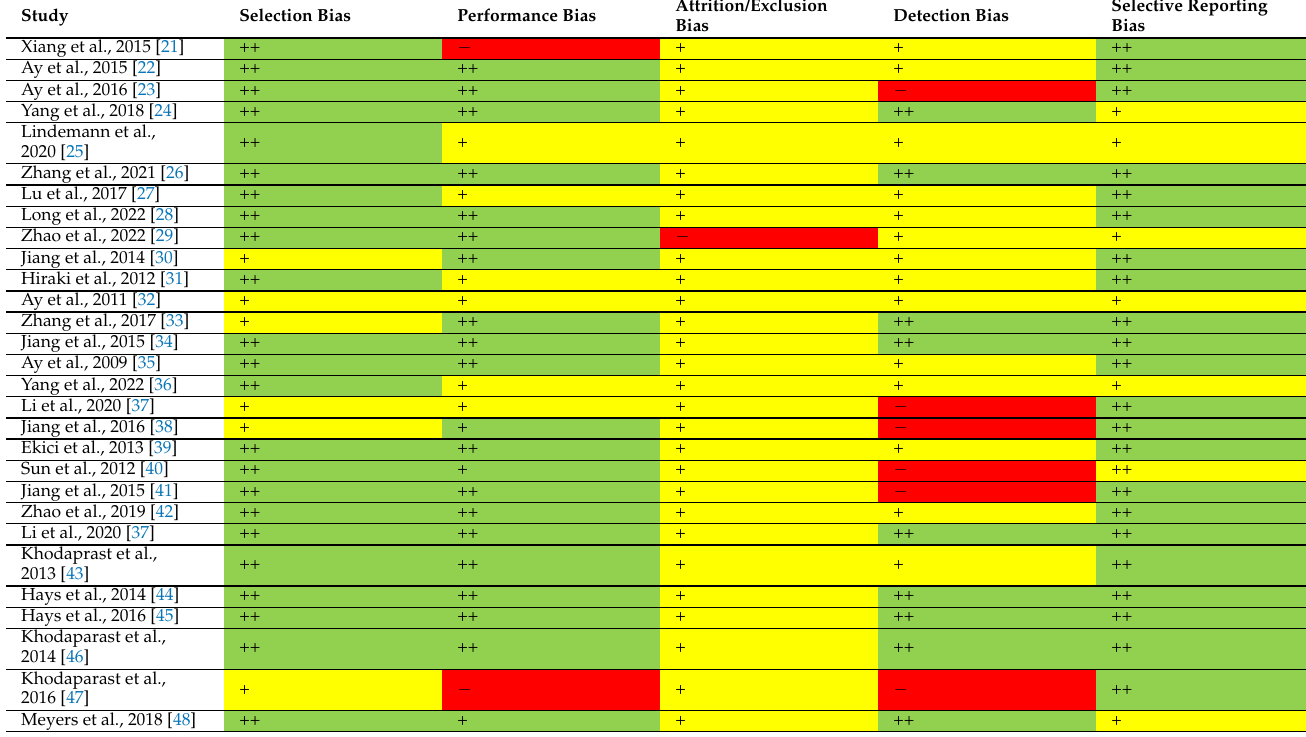
Table 1. Rating the risk of bias for studies included in the analysis